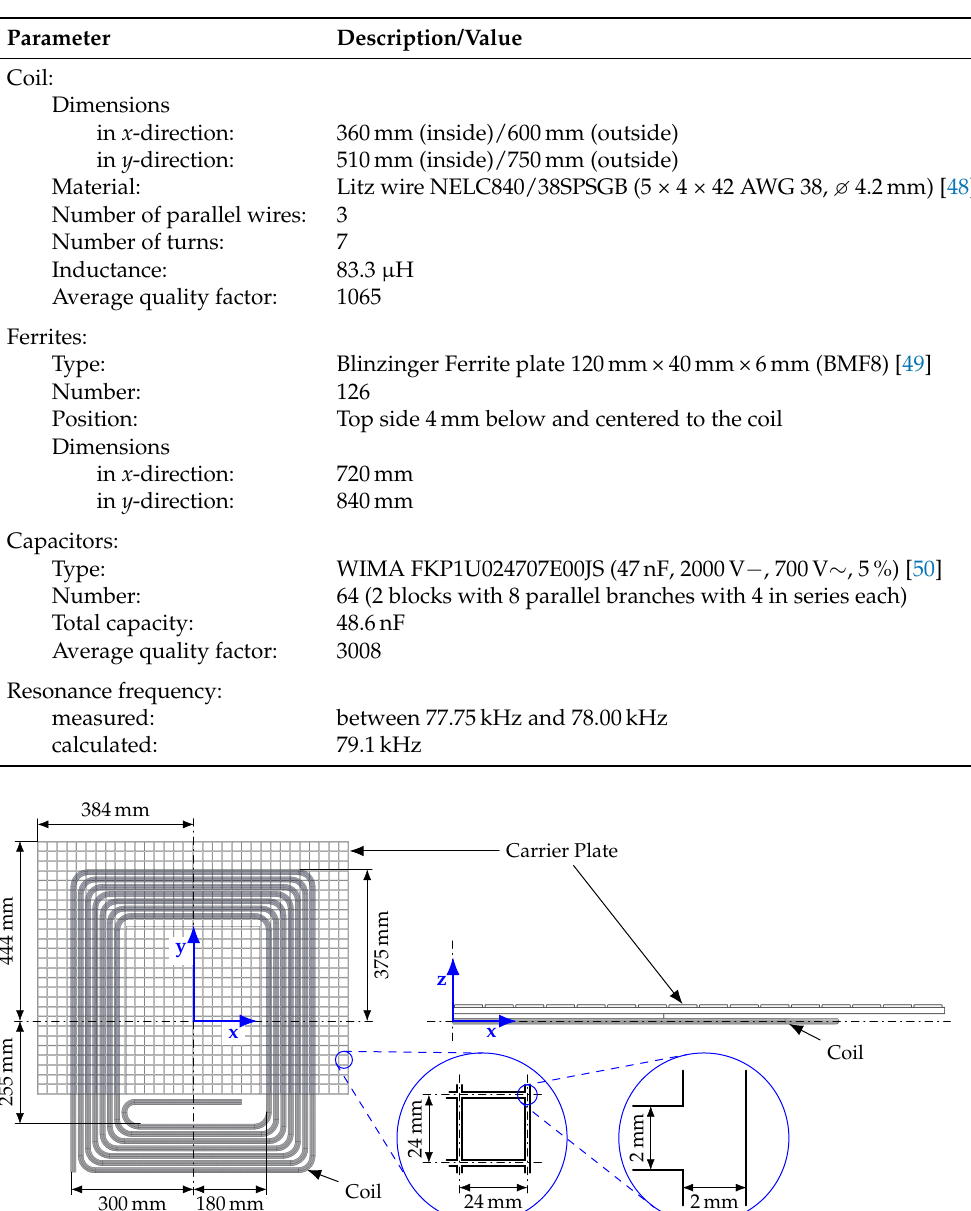
Table 1. Parameters of the series resonant circuit of the wireless charging system ground assembly.